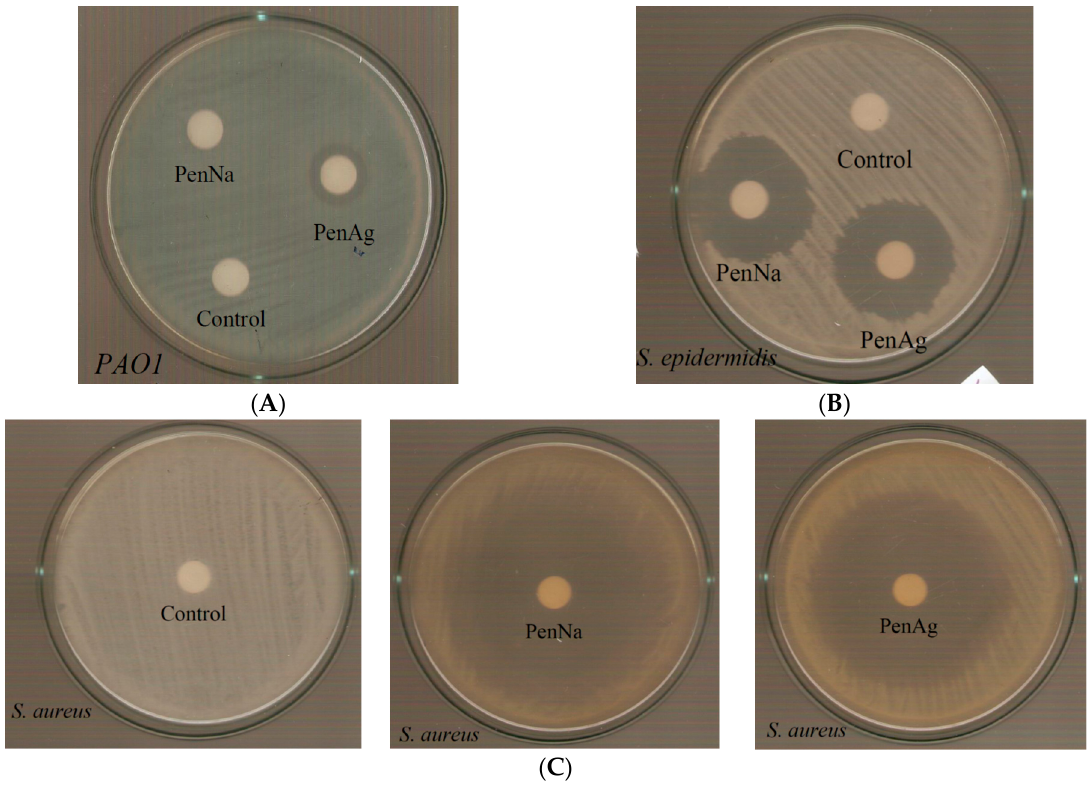
Figure 8. Inhibition zones which are grown in Pseudomonas aeruginosa ( A ), Staphylococcus epidermidis ( B ), and Staphylococcus aureus ( C ) for PenAg and PenNa .